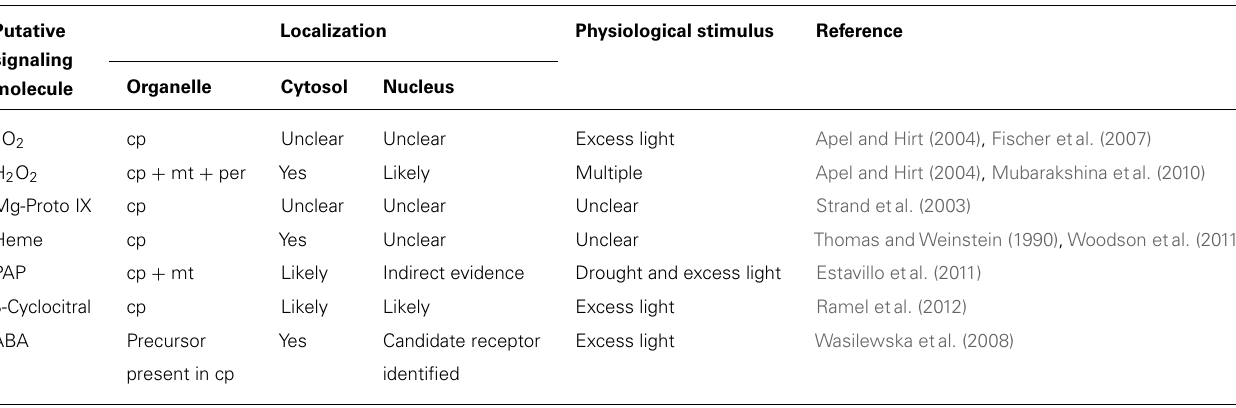
Table 2 | Characteristics of putative retrograde signaling molecules. Putative